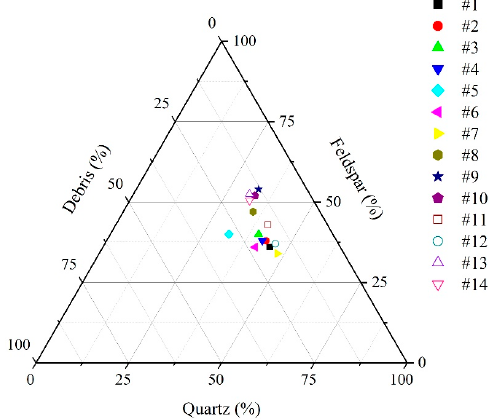
Figure 3. Ternary diagram shows the compositions of quartz, feldspar and debris of the samples.